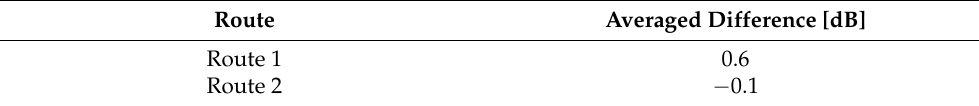
Table 4. Averaged differences between normal three-axis and separate measurements.